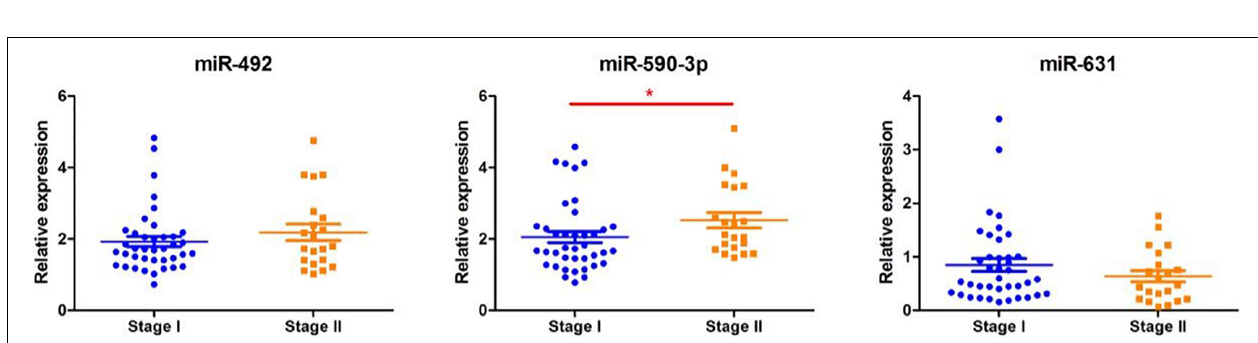
FIGURE 4 | The relationship between miRNA expression levels in serum and with clinical stage. There were no significant differences between miR-492 or miR-631 expression levels in serum with clinical stage. The expression level of serum miR-590-3p increases with clinical stage. * p < 0.05.